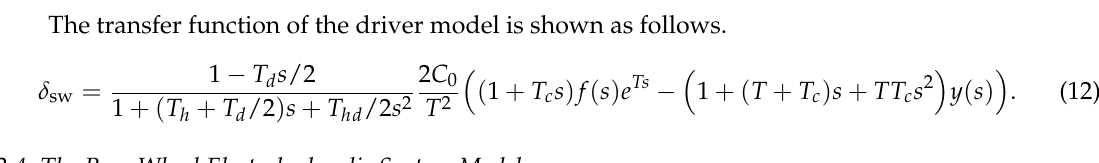
Figure 4. The driver – vehicle closed-loop system.